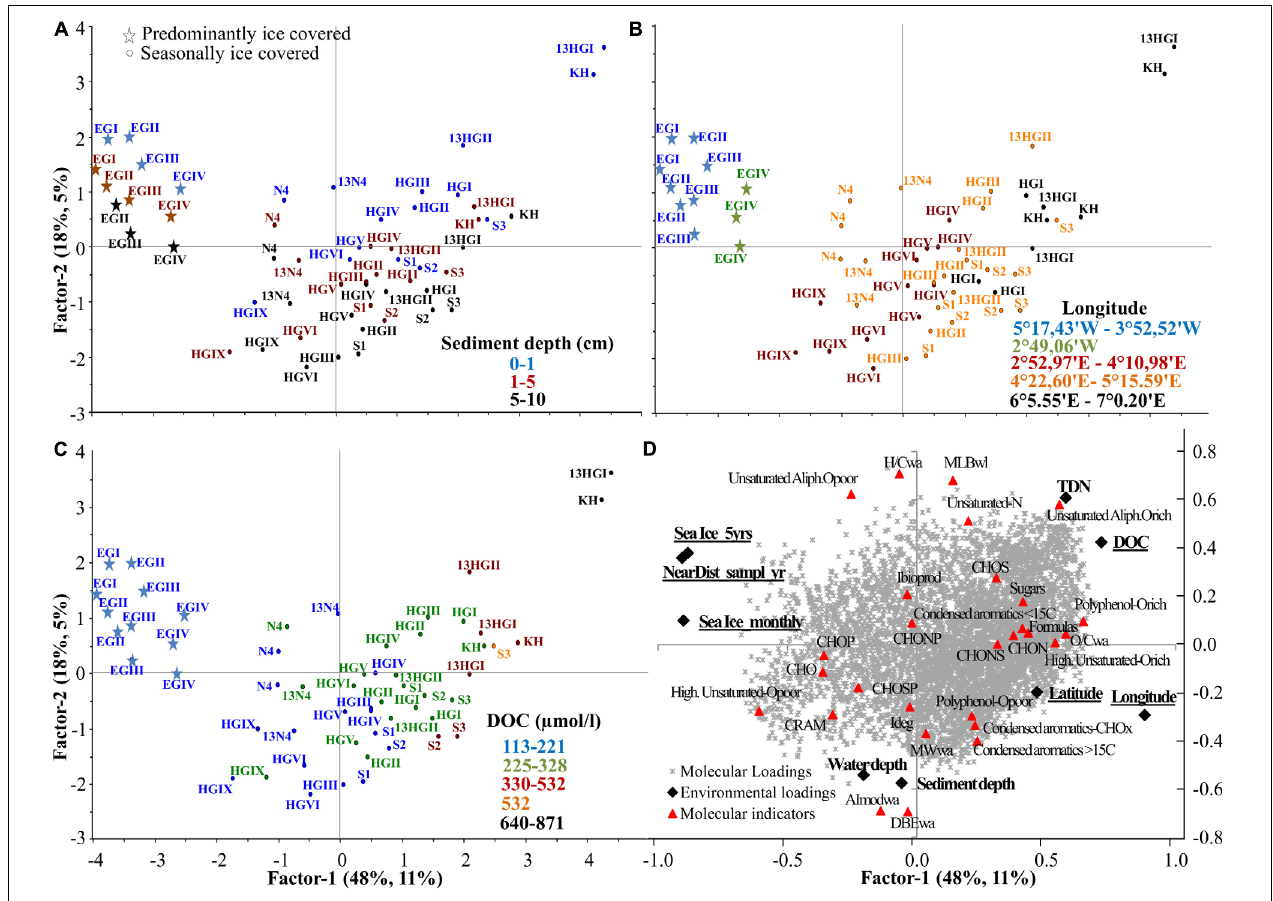
FIGURE 5 | Partial Least Square (PLS) analysis of all porewater samples with factor 1 explaining 48 and 11% of the environmental and molecular variability, respectively, and factor 2 explaining 18 and 5%. (A) Scores plot (samples indicated by the name of the station, Supplementary Table S1 ) color coded with sediment depth, (B) longitude and (C) DOC concentration, and (D) correlation of environmental (X loadings) and molecular loadings (Y loadings), passively displaying the evaluated molecular categories, ratios and indices (see molecular indicators in Supplementary Figure S1 and Supplementary Table S2 ). Underlined environmental variables significantly influence porewater DOM composition. Sea ice variables: Sea Ice_montly, Sea Ice_5yrs and NearDist_sampl_yr, stand for sea ice monthly average, 5 years average and nearest distance to the ice margin (see section “Sea Ice Conditions,” Supplementary Table S1 ).